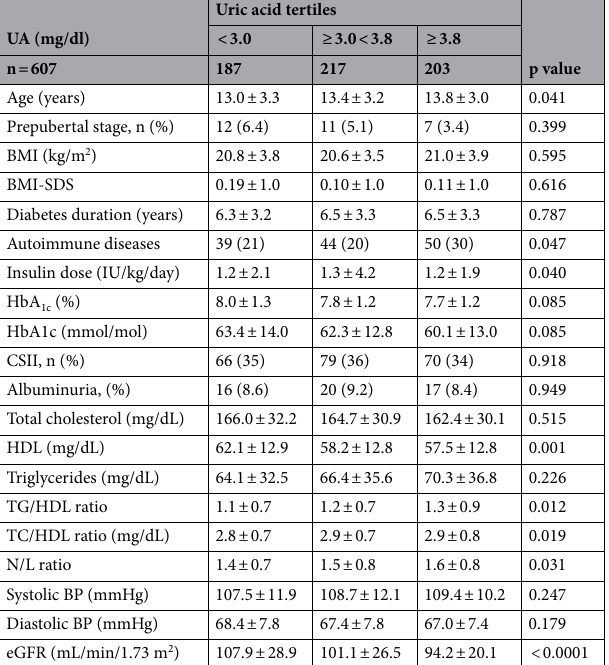
Table 3. Anthropometric and biochemical features in girls according to tertiles of uric acid. Data are expressed as mean ± SD, n (%). p values are for trends across tertiles. HbA 1c : glycosylated hemoglobin, CSII: continuous subcutaneous insulin infusion. MDI: multiple doses of insulin. IU/Kg/day: insulin dose pro Kg Day. TG/HDL ratio: triglycerides to HDL ratio. Chol/HDL ratio: Cholesterol to HDL ratio. SPISE: single-point insulin sensitivity estimator N/L ratio: Neutrophil/Lymphocyte ratio. BP: blood pressure. eGFR: estimated glomerular filtration rate.